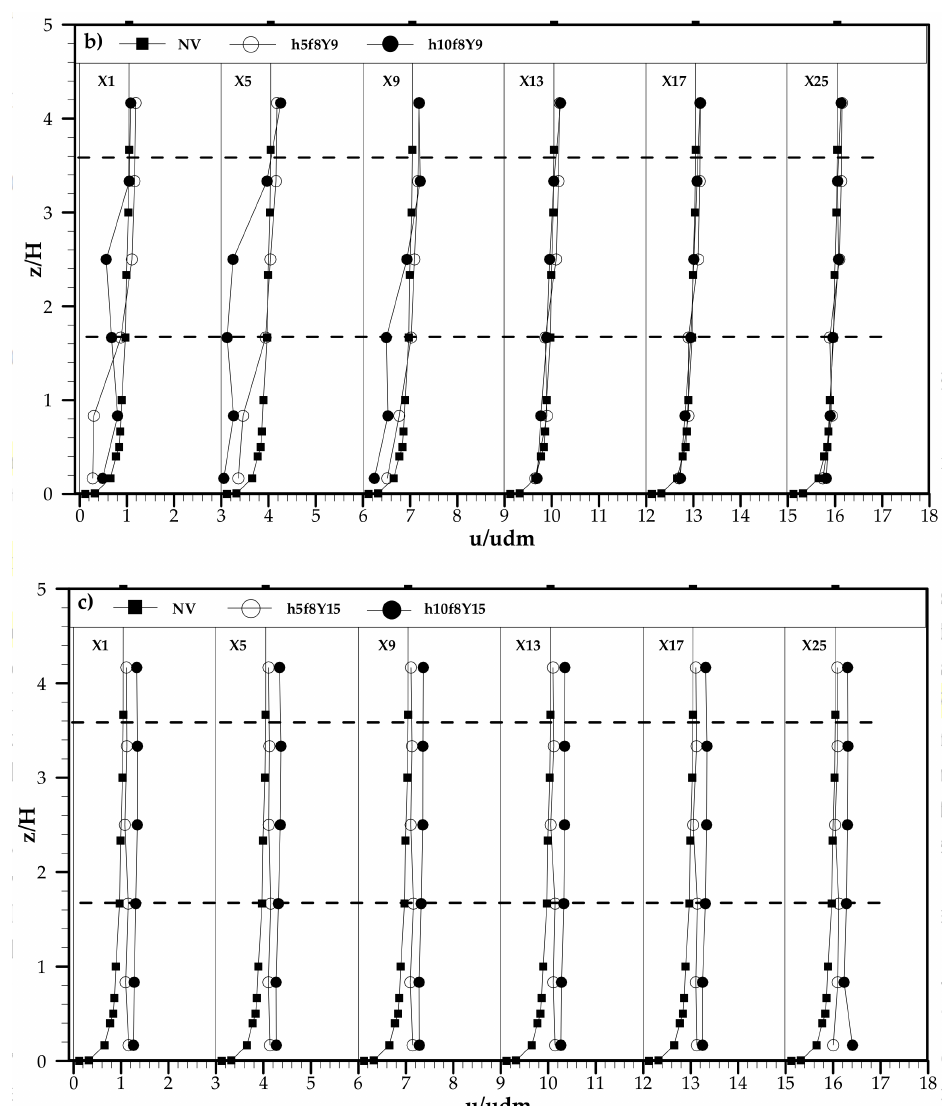
Figure 7. Non-dimensional streamwise velocity distributions along vertical direction at different streamwise sections for both vegetation heights and φ = 0.08: ( a ) Y3; ( b ) Y9; ( c )